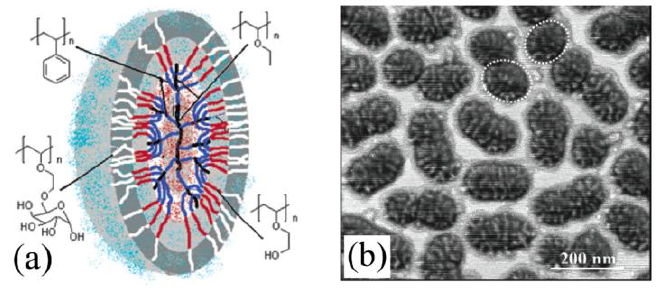
Figure 8. (a) Example of an amphiphilic core-shell-corona architecture with segregated branching points, and (b) AFM image in the phase contrast tapping mode showing a nodular core morphology and confirming the presence of a hydrophilic shell in the core-shell-corona molecules. Adapted from Reference 43 by permission from the American Chemical